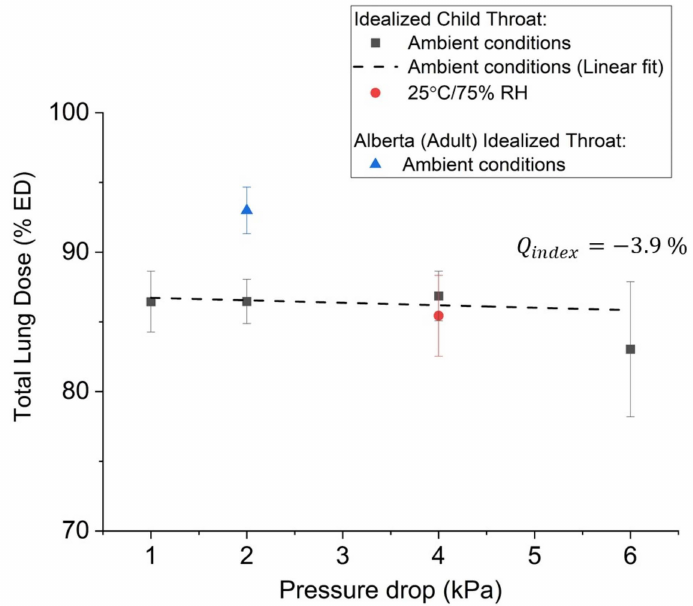
Figure 6. TLD measured in anatomical throat models as a function of pressure drop and variations in relative